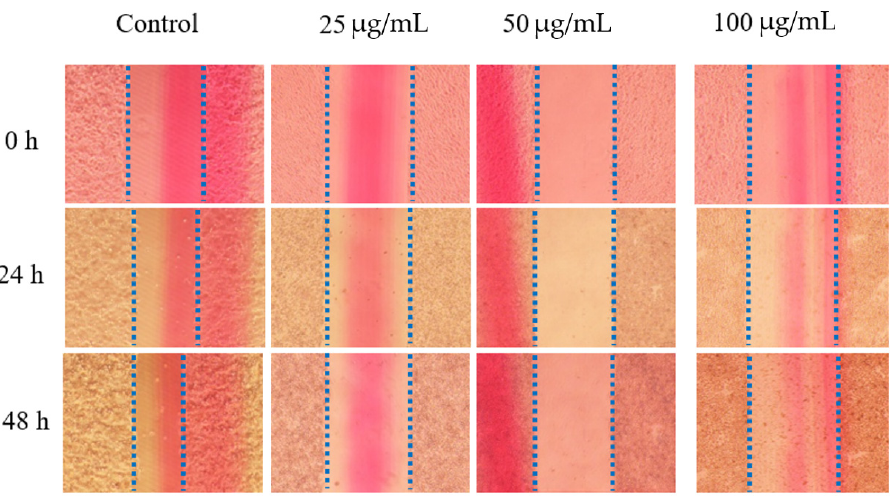
Figure 2. ( a ) Control; ( b ) 50 μ g/mL; ( c ) 100 μ g/mL; ( d ) 200 μ g/mL. The effect of RLE on the colony formation rate of HT-29 cells.